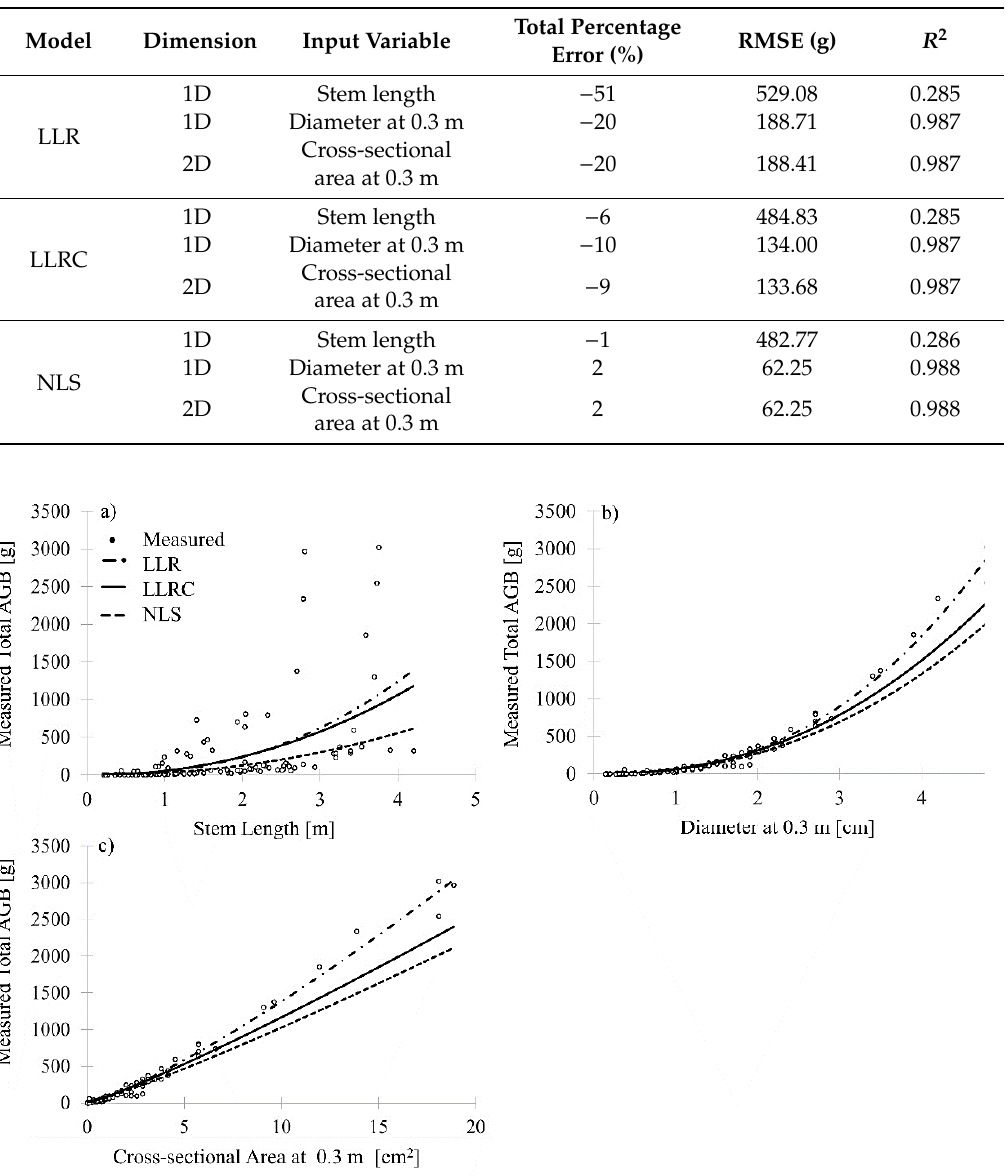
Table 4. Model performance for multispecies tree total AGB prediction using 1D and 2D input parameters (all p values < 0.001).